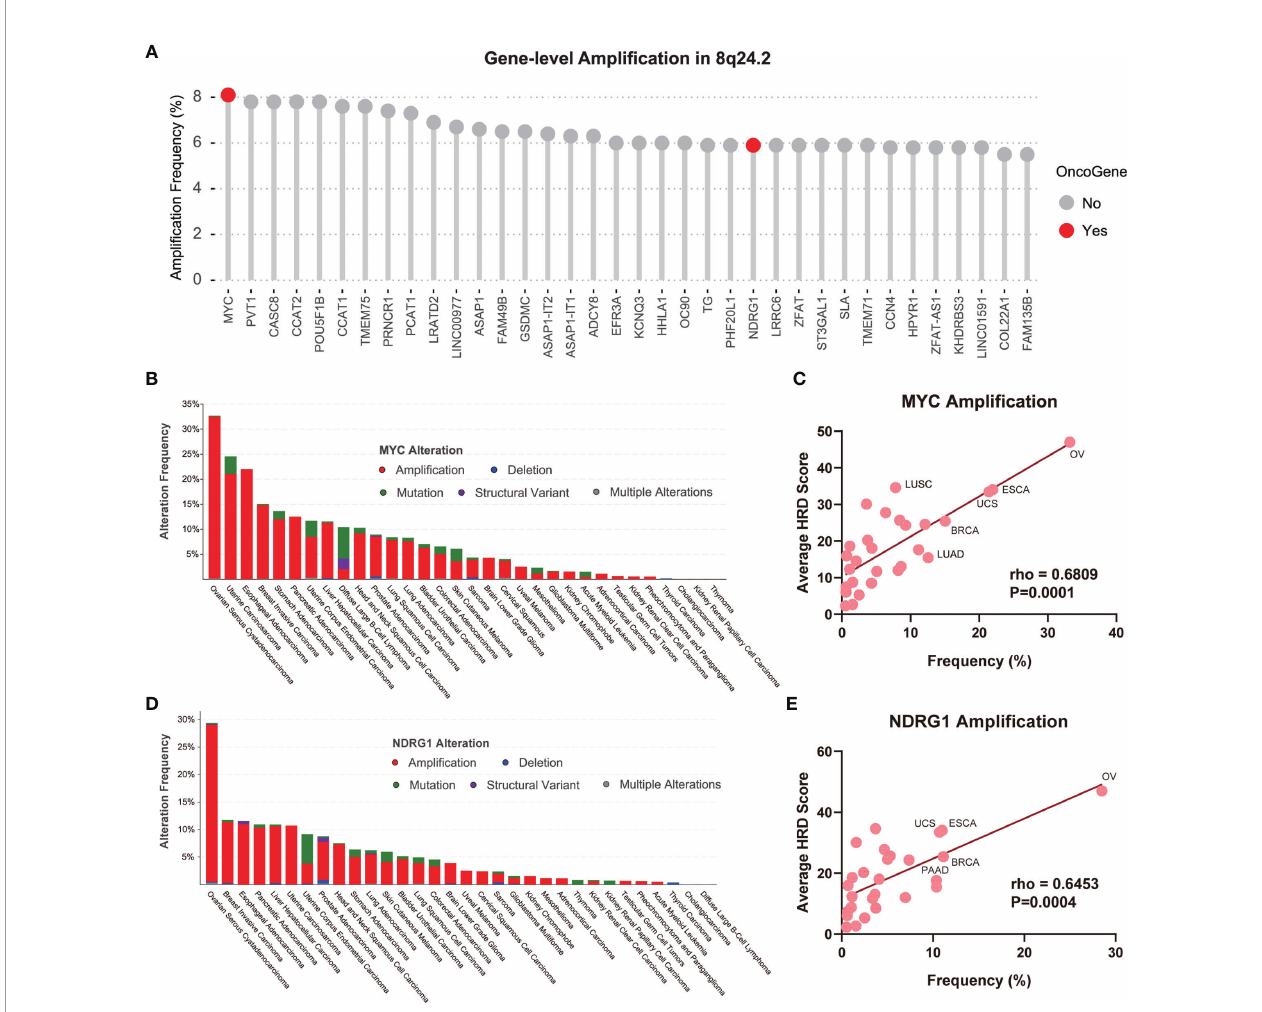
FIGURE 4 | MYC and NDRG1 ampli fi cations as gene-level CNV biomarkers for pan-cancer HRD detection. (A) The ampli fi cation of the gene-level CNA of 8q24.2 in TCGA. Red: oncogene, gray: non-oncogene. (B) The alteration type and frequency of MYC in various tumors, red: ampli fi cation, blue: deletion, green: mutation, purple: structural variant, gray: multiple alterations. (C) The linear regression graph of the ampli fi cation frequency of MYC and the average HRD score of tumors. (D) The alteration type and frequency of NDRG1 in various tumors. (E) The linear regression graph of the ampli fi cation frequency of NDRG1 and the average HRD score of tumors. Statistical analysis was performed by Spearman test in (C, E)